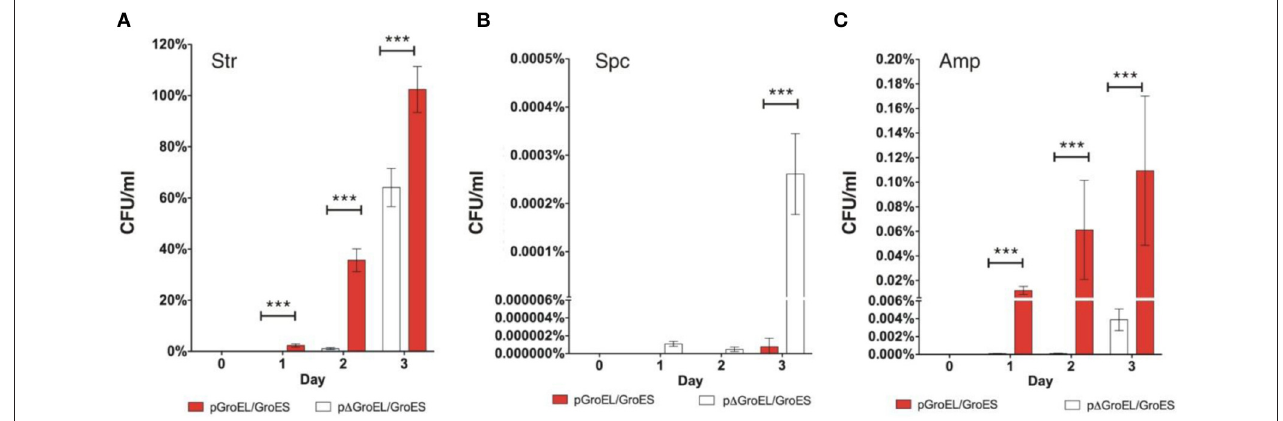
FIGURE 1 | Chaperonin dependent antibiotic resistance development following sub-inhibitory selection. Percentage of colonies growing on inhibitory concentrations of the indicated antibiotics used for selection with or without over-expression of GroEL/GroES (pGroEL/GroES), or an empty control plasmid (p 1 GroEL/GroES). The number of cfu growing on inhibitory antibiotic plates was normalized to total cfu count (Each data point consists of 2-4 experimental repeats each composed of 2-4 technical repeats. Error bars show SD). Day 1: pGroEL/GroES vs. p 1 GroEL/GroES p < 0.0001 ( *** ), day 2: pGroEL/GroES vs. p 1 GroEL/GroES p < 0.0001 ( *** ), day 3: pGroEL/GroES vs. p 1 GroEL/GroES p < 0.0001 ( *** ). Note the split y-axis used to enable visualization of large differences within the same graph. (A) Str, streptomycin; (B) Spc, spectinomycin; (C) Amp, ampicillin.